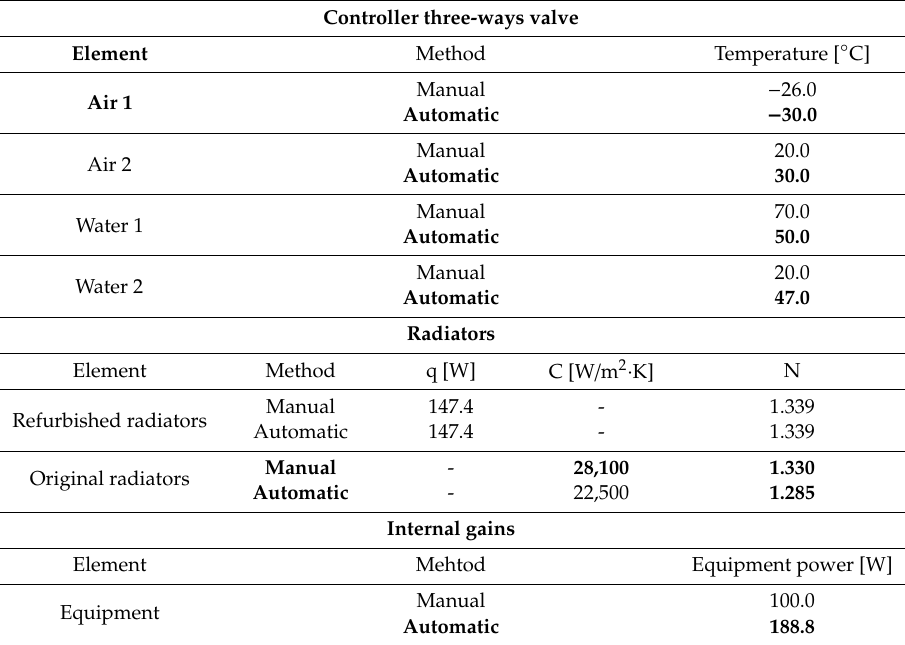
Table 13. Plants and internal gains settings for resulting models from manual and automatic calibration (bold when